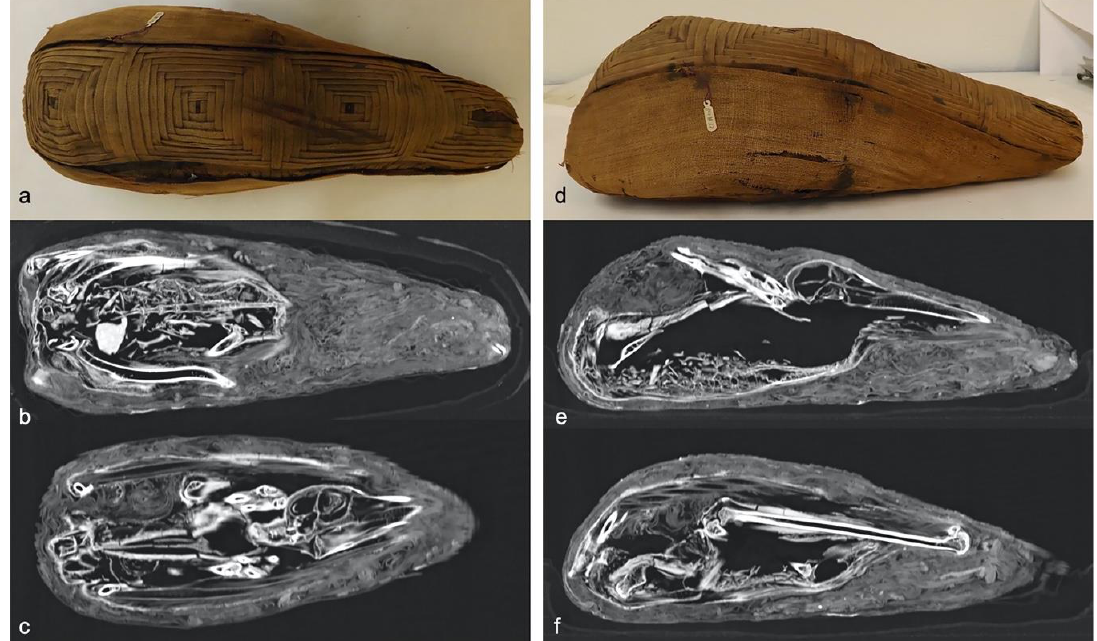
Figure 9. Figure showing the contents of mummy MFA acc. no. RES.14.33 as revealed by dual energy CT scanning. Images ( a ) anterior posterior photograph, ( b ) coronal CT reformat showing the two femora located at the base of the bundle with some loose skeletal debris, ( c ) coronal CT reformat showing the skull, ( d ) lateral photograph, ( e ) sagittal reformat showing the large air-filled void inside the body, the fragmented elements and loose debris at the base, and the additional section of spine located behind the skull, and ( f ) sagittal CT reformat showing the radius. [Photographs and radiographs created by author for the Ancient Egyptian Animal Bio Bank.].